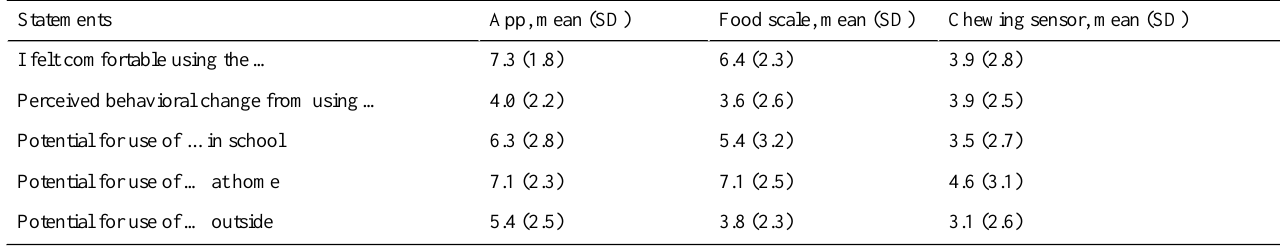
Table 2. Perceived usability and acceptability of the smartphone app and devices, answered using 10-point Likert scales, ranging from 0 (completely disagree) to 9 (completely agree).